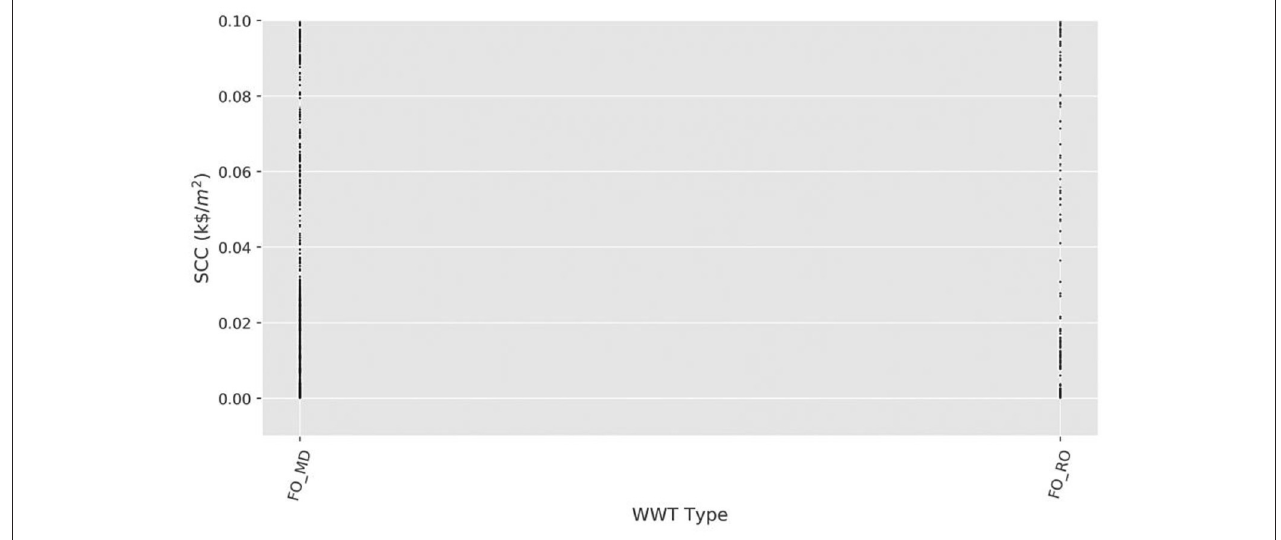
FIGURE 9 | Social cost of carbon vs. WWT type for scenario 2 across all individual neighborhoods with SCCs less than 0.10 k$/m 2 , i.e., the 99.7th percentile of SCC. Each neighborhood is represented by a single dot in the